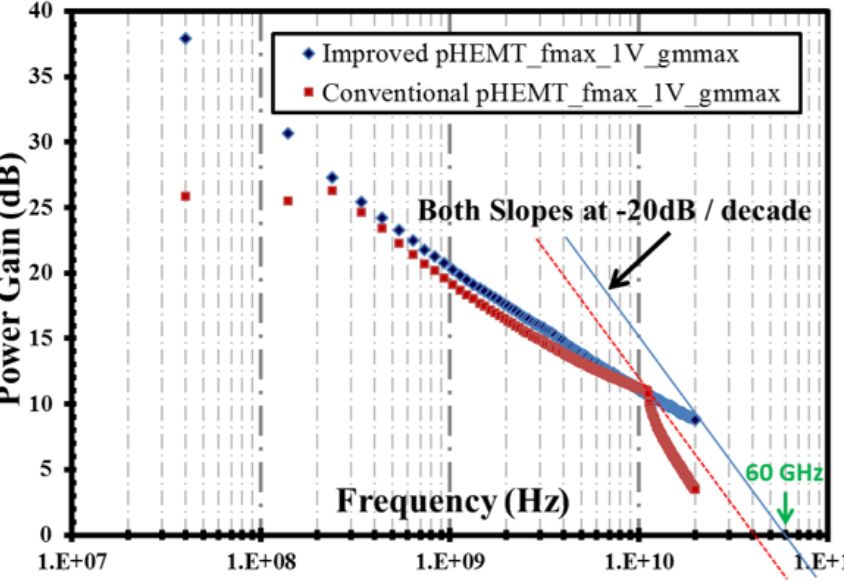
Figure 14. Unilateral power gain or maximum frequency (f max ) at g mmax for V DS = 1 V